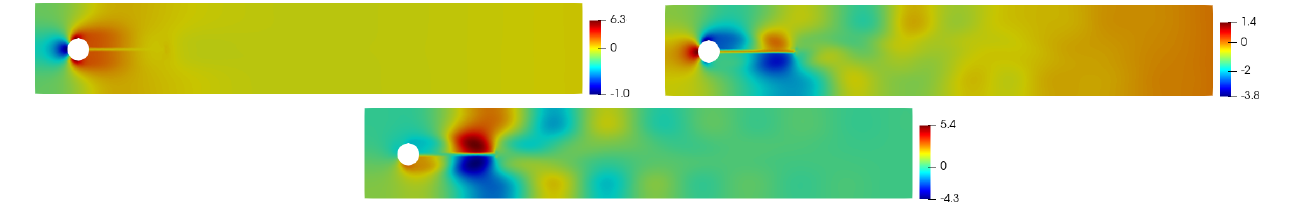
Figure 5. The first three POD modes for the fluid pressure p f .